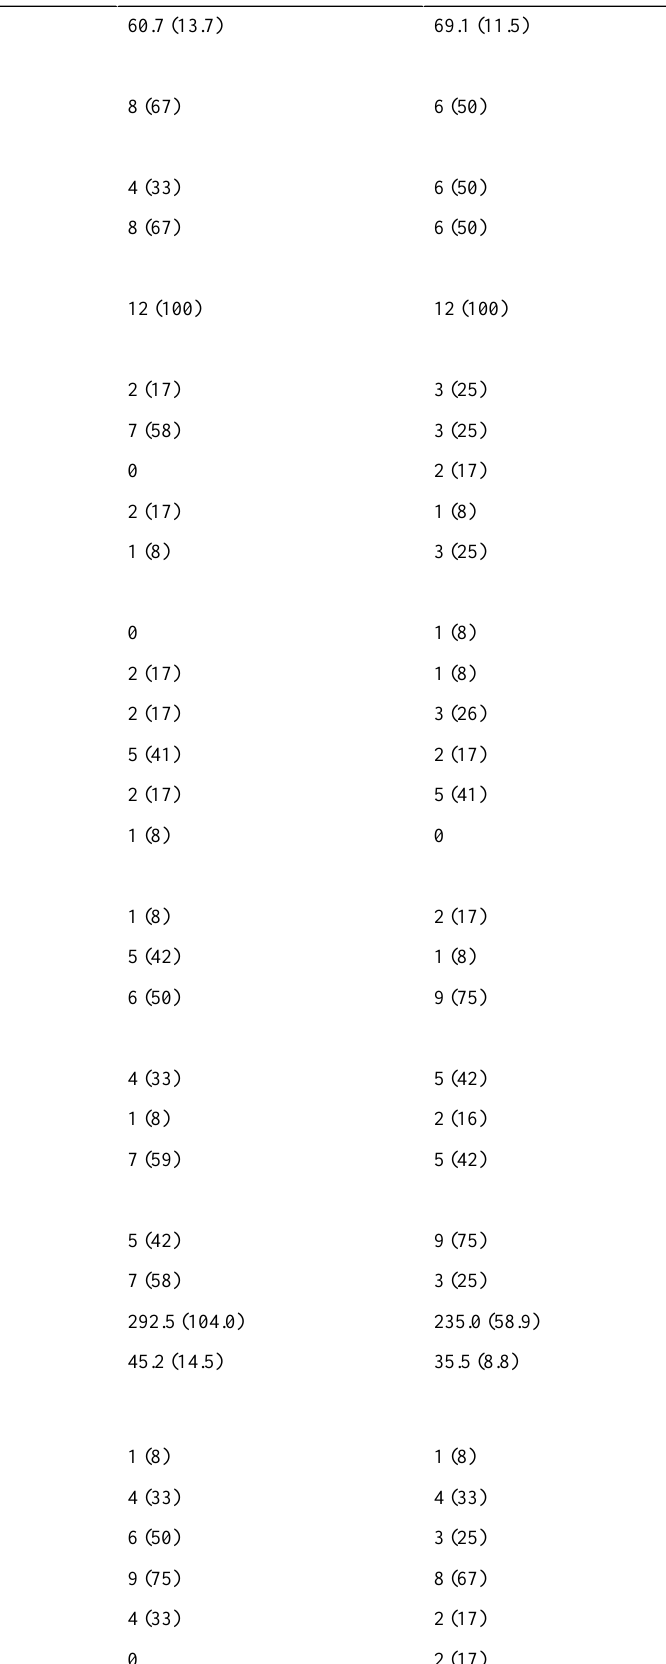
Table 1. Demographic and clinical characteristics by FOOTFIT and FOOTFIT+ groups at baseline